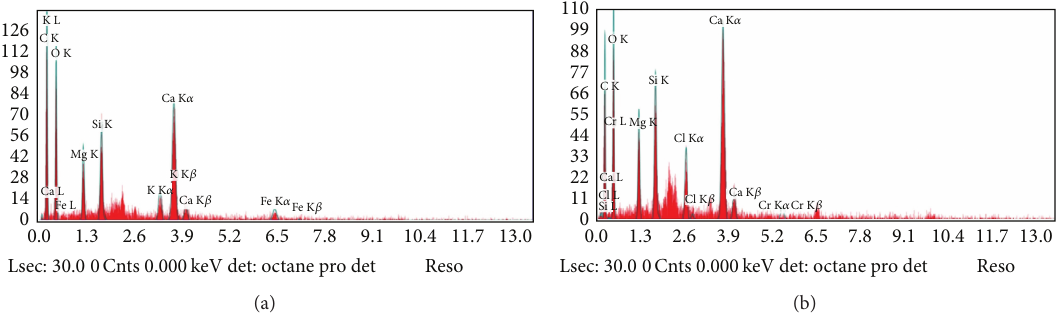
Figure 2: (a) EDX analysis of Fe treated rice husk before adsorption. (b) EDX analysis of Fe treated rice husk after simultaneous adsorption of Cr(VI) and